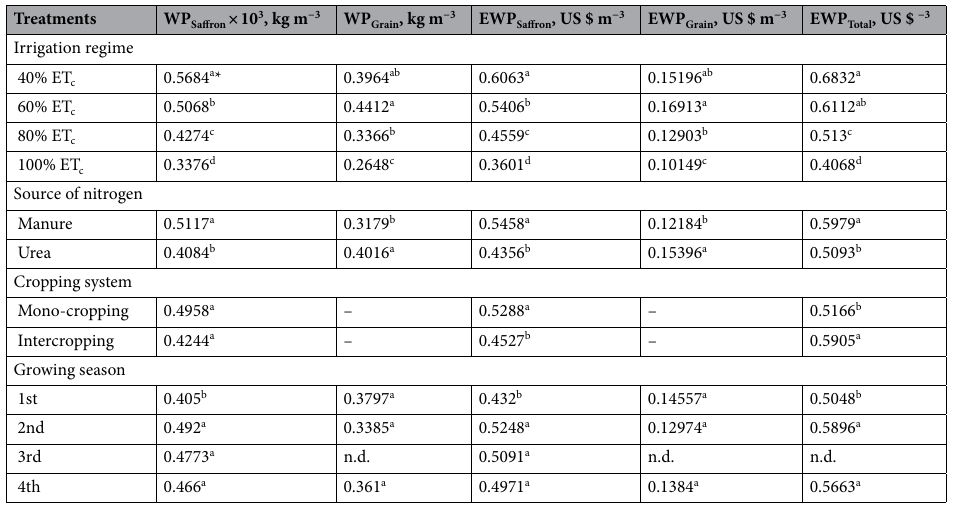
Table 5. Means for saffron and wheat-grain physical water productivities (WP Saffron and WP Grain , respectively), saffron, wheat grain and total economic water productivities (EWP Saffron , EWP Grain and EWP Total , respectively). *Means followed by similar letters in each column for each factor and each trait are not significantly different at 5% level of probability according to Tukey test. n.d. not